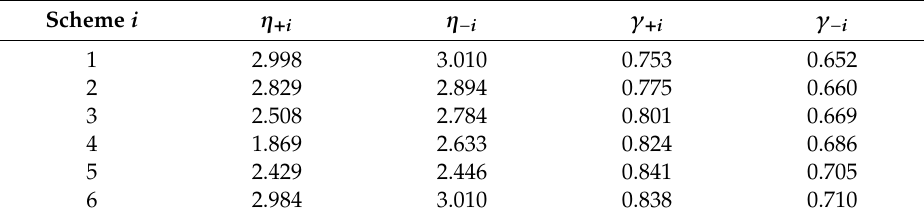
Table 10. Derivative indicator decision matrix X .